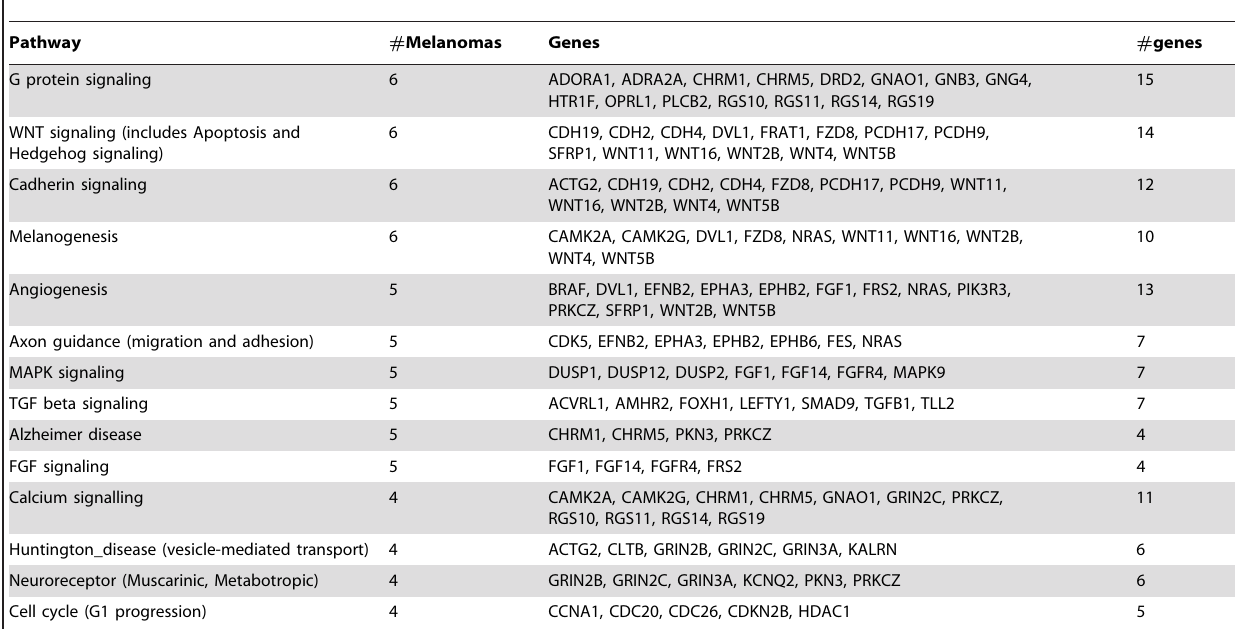
Table 3. Pathways identified by network-guided